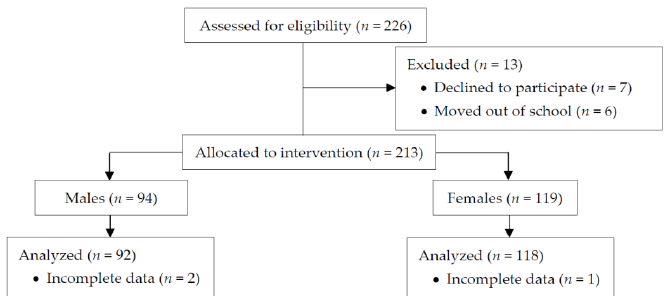
Figure 1. Flow diagram of the progress through the phases of the TAKE 10! ® classroom-based PA curriculum intervention, presented according to CONSORT statement recommendations [13].